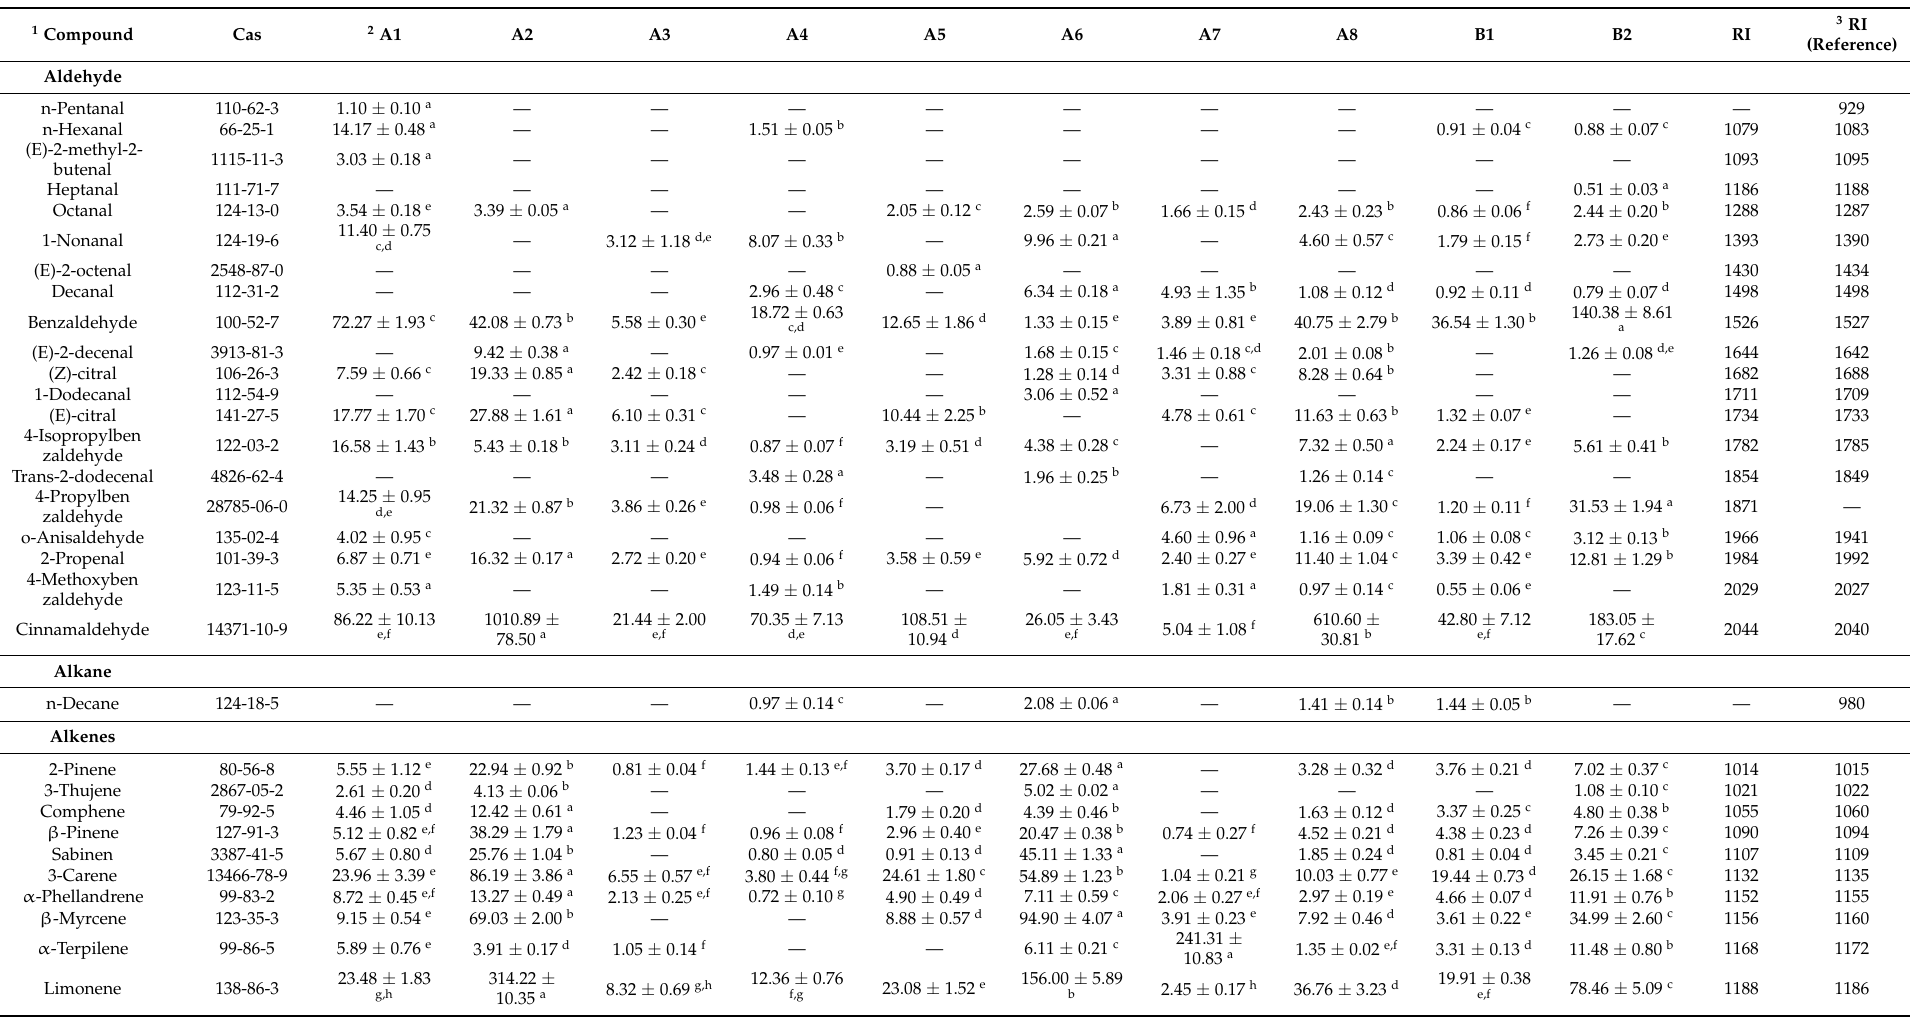
Table 3. Identification and quantification of volatile compounds in each group ( µ